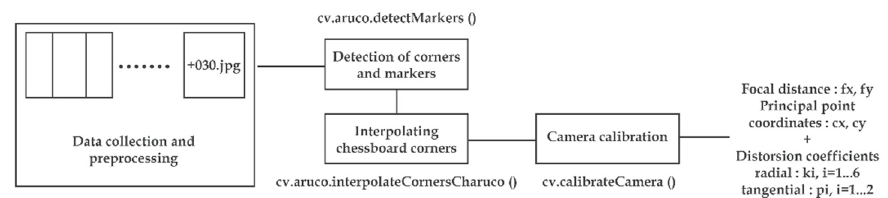
Figure 5. Workflow of geometric calibration on OpenCV.